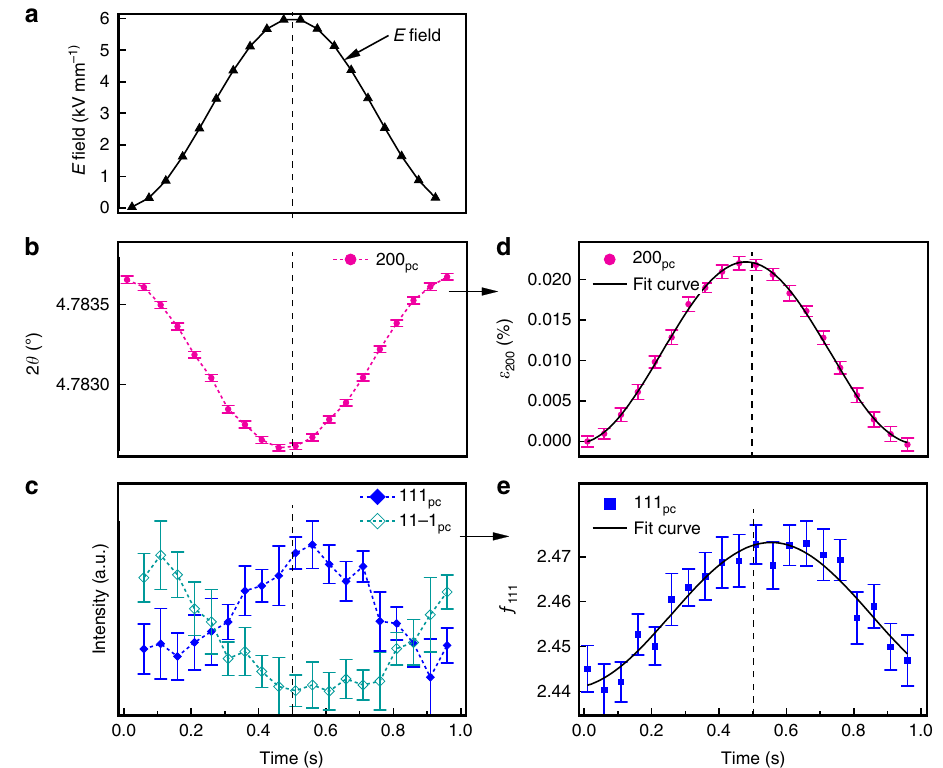
Fig. 2 Strain response to sinusoidal electric fi eld. a Sinusoidal electric fi eld, E , demonstrated for the 1 Hz measurement; b 200 pc peak position, 2 θ ; c intensities of 111 pc /11 (cid:1) 1 pc re fl ections, and calculated d 200 pc lattice strain, ε 200 ; and e non-180° 111 pc domain texture, f 111 . The error bars arise from pro fi le fi tting using Gaussian peak functions on individual single and double peaks. The dashed line is used here to indicate amplitude of electric fi eld at ~0.5 s for the 1 Hz electric fi